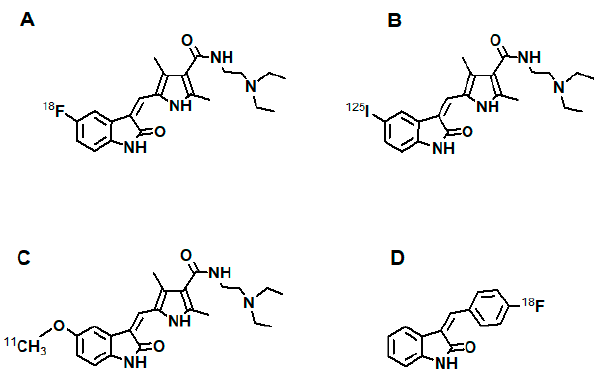
Figure 3. Sunitinib-based VEGFR imaging agents; ( A ): [ 18 F]5-F-sunitinib [255]; ( B ): [ 125 I]5-I-sunitinib [254]; ( C ): [ methoxy - 11 C]5-methoxy-sunitinib [256,257]; ( D ): [ 18 F]3-(4 ′ -fluorobenzylidene)indolin-2-one